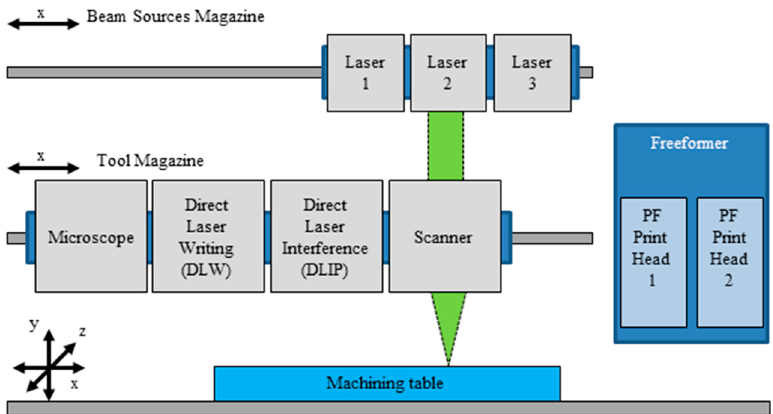
Figure 1. Conception of the universal micromachining platform for manufacturing and marking of Micro Physiological Systems (MPS) using latest key technologies: laser micro cutting of polymer foils, laser micro- and sub-micro-structuring (direct laser writing (DLW), Scanner and Direct Laser Interference Patterning-module (DLIP-module) of polymer foils, 3D printing of polymer components as well as optical inspection and online process control.